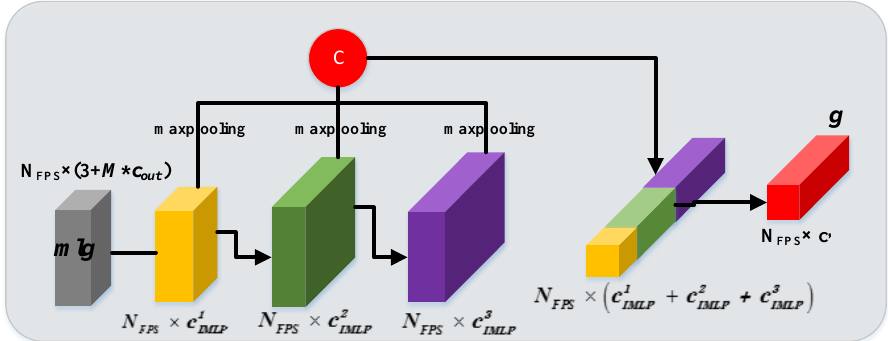
Figure 6. The architecture of IMLP.